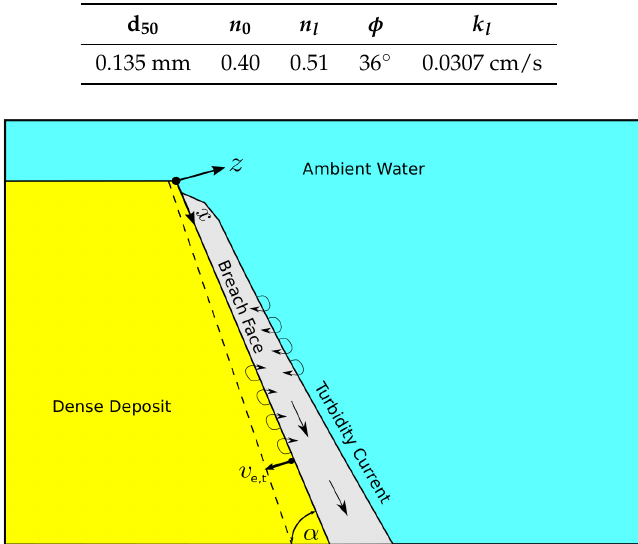
Table 1. The properties of the sand used in the experiments [18].